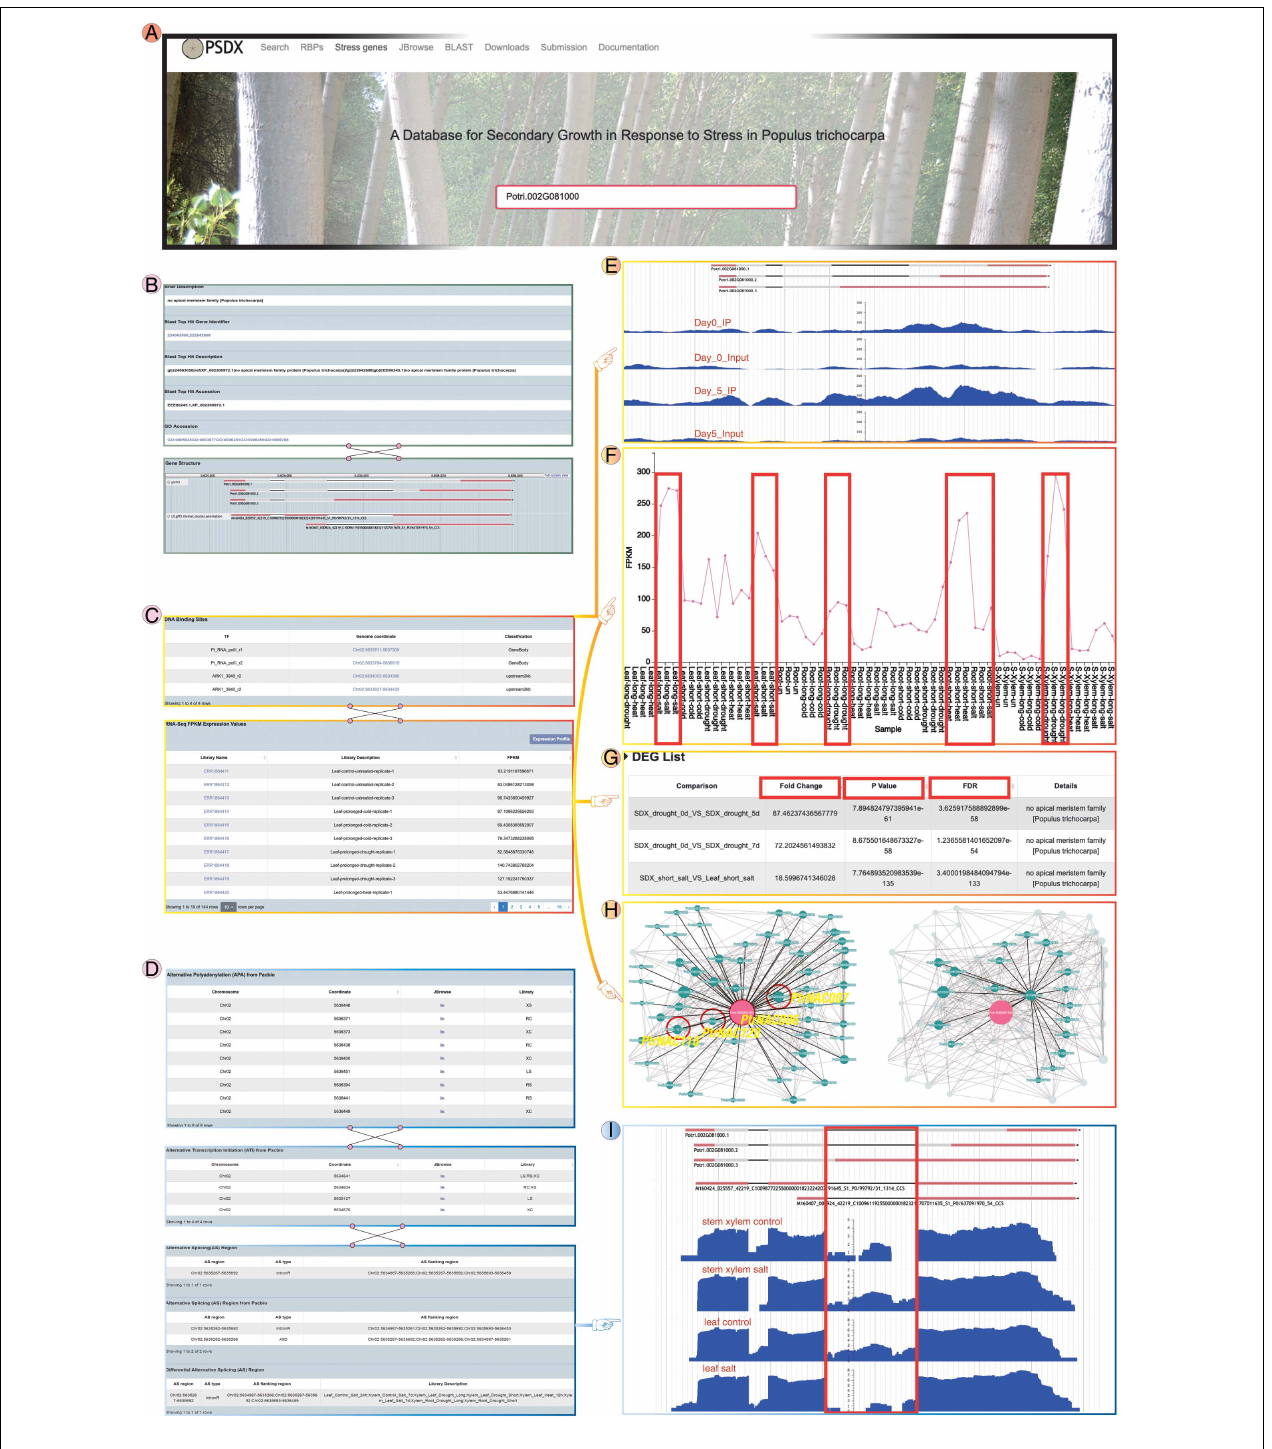
FIGURE 6 | Potri.002G081000 ( PtrNAC006 ) was selected as an example to show multi-dimensional omics levels in PSDX. (A) PSDX main search interface with Potri.002G081000 ( PtrNAC006 ) as an example. (B) A brief introduction and gene structure of PtrNAC006 . (C) Transcriptional regulation of PtrNAC006 . The top panel is the DNA peaks of PtrNAC006 . All the FPKM values are provided in the bottom panel. (D) Post-transcriptional regulation of PtrNAC006 , which including APA sites, ATI, AS events from short-read RNA-seq and PacBio Iso-seq, and differential AS events. (E) Wiggle plot shows increased H3K9ac levels under drought stress. (F) PtrNAC006 is significantly up-regulated under drought and salt stress, respectively. (G) Differential expression of PtrNAC006 in different organs and stresses, users can re-rank the DEG with fold change, P -value, and FDR. (H) Co-expression network of PtrNAC006, which connected with other drought-responsive genes Potri.007G099400 ( PtrNAC007 ), Potri.011G123300 ( PtrNAC118 ), and Potri.001G404100 ( PtrNac120 ). (I) The second intron of PtrNAC006 tends to be included (intron retention) under salt stress in stem xylem. However, the intron tends to be fully spliced under salt stress in the